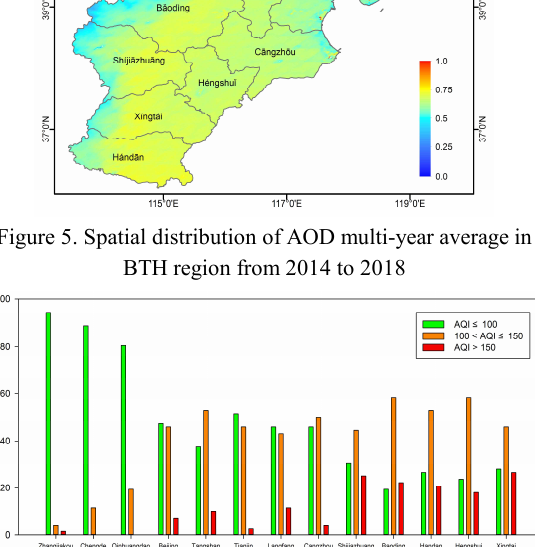
Figure 6. Statistics of urban air quality levels in BTH region from 2014 to 2018